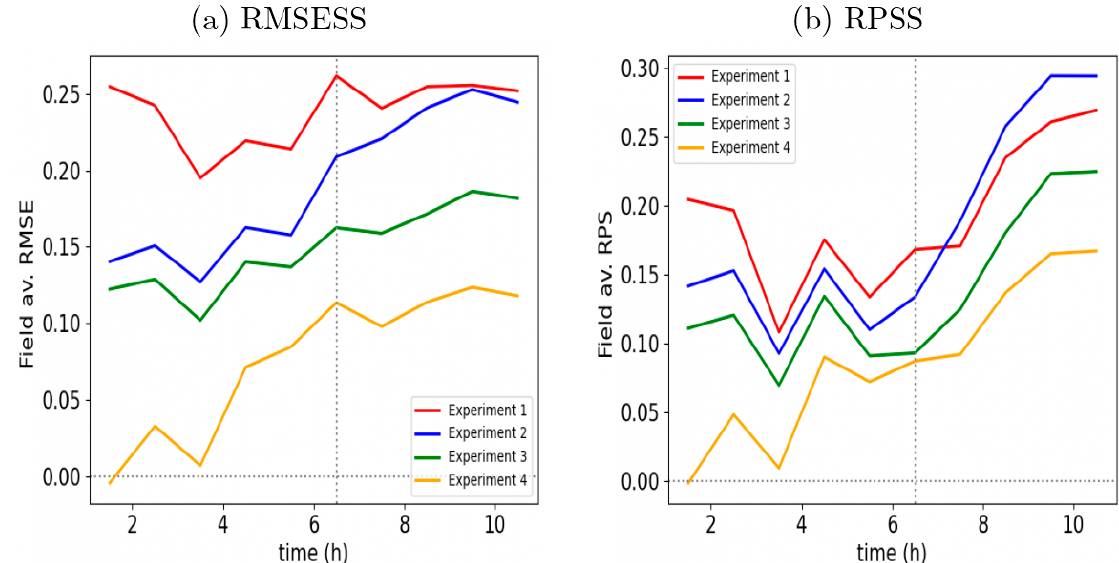
Figure 10. RMSESS and RPSS values (see Section 3.3) as a function of time for the experiments in this study. The experiments utilize different values of 𝛽 (see Table 2). Positive skill scores indicate improved skill relative to the control experiment. The dotted vertical line demarcates the analysis and forecast periods.